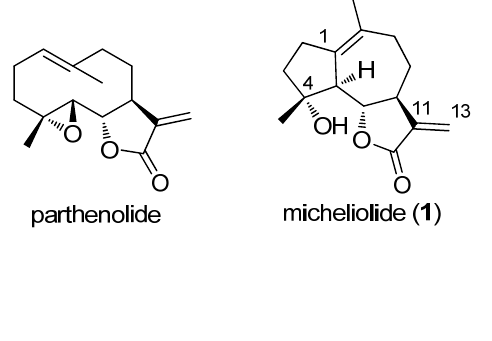
Figure 1. Structure of parthenolide (PTL) and micheliolide (MCL, 1